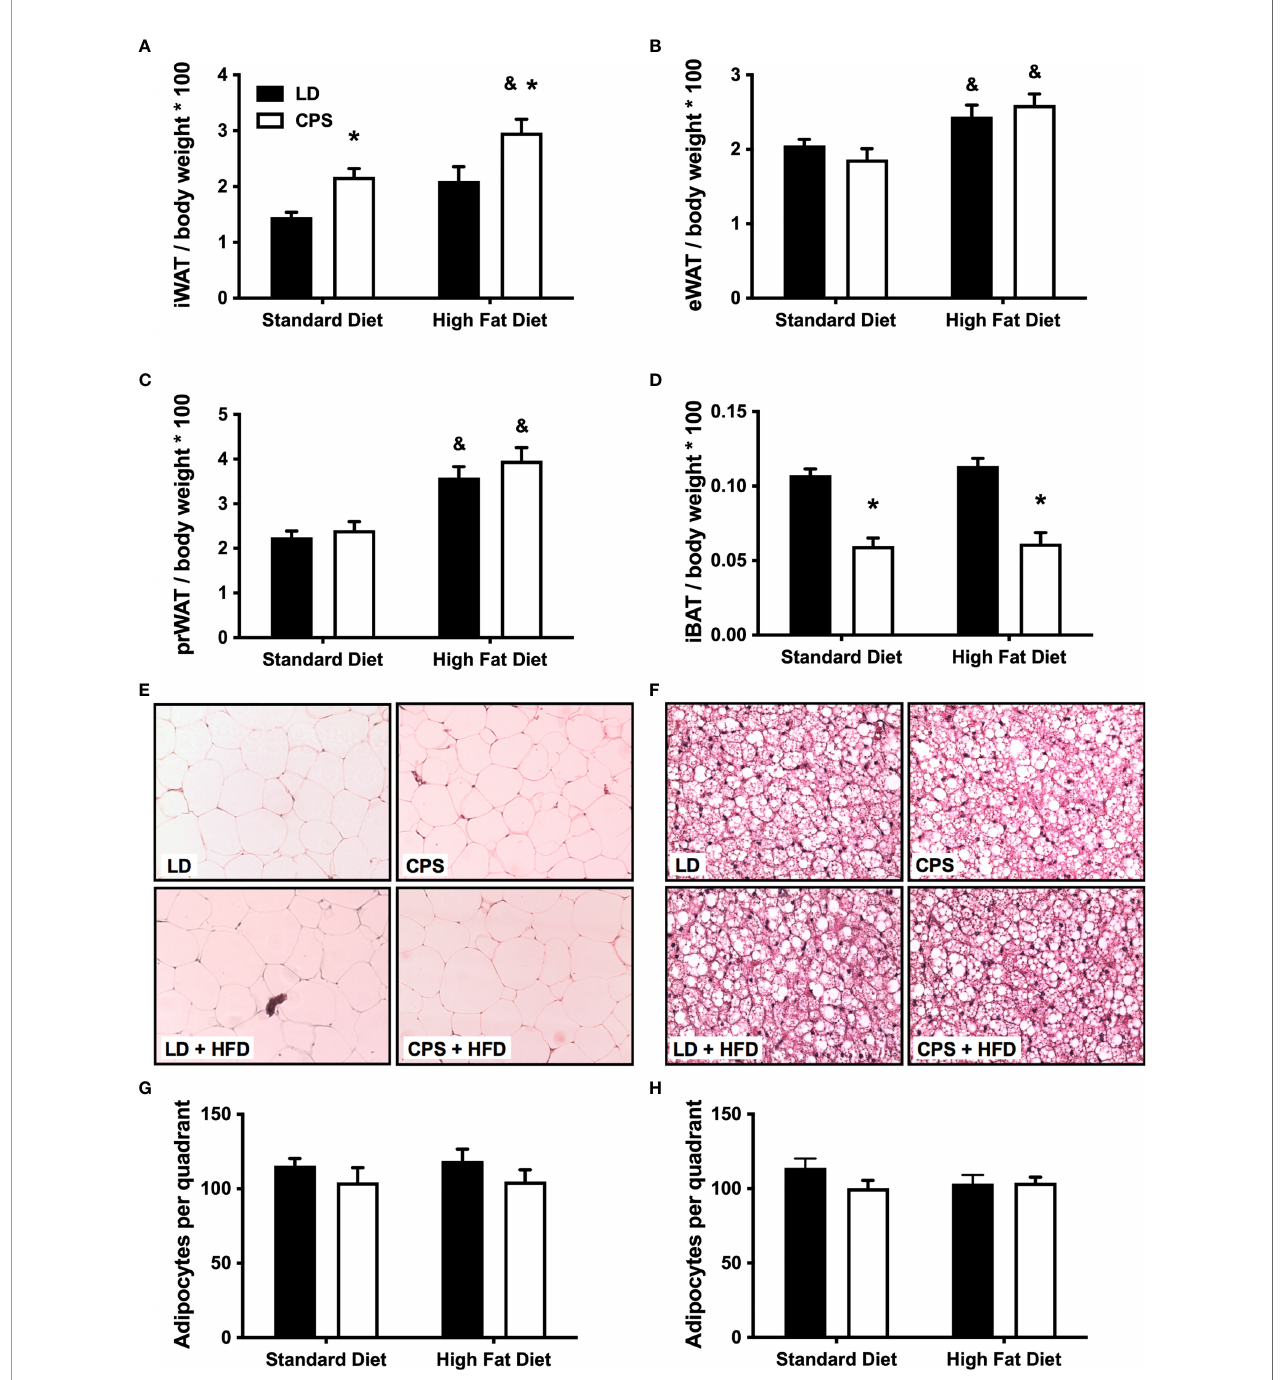
FIGURE 6 | Effects of gestational chronic phase shift of photoperiod in recruitment of adipose tissue depot. Upper panel displays the weight of whole adipose tissue depots adjusted by full-body weight of 200-day-old rats fed with standard diet or high-fat diet. (A) Inguinal adipose tissue, (B) epigonadal adipose tissue, (C) perirenal adipose tissue, (D) interscapular brown adipose tissue. Middle panel displays representative H&E staining of (E) 10× perirenal white adipose tissue and (F) 40× interscapular adipose tissue histological sections. Lower panel displays the corresponding cell number counts as shown in (G) from white adipose tissue and (H) from brown adipose tissue. Data are mean±SEM. Black bars: LD, adult rats that had been gestated under control 12:12 (LD) photoperiod. White bars: CPS, adult rats that had been gestated under chronic phase shift (CPS) photoperiod. Standard diet: animals fed with Prolab ® RMH 3000, High-fat diet: animals fed with 45% high-fat diet for 12 weeks. n = 8 per group. *LD + HFD; CPS + SD and CPS + HFD are different from LD + SD ( p < 0.05 pairwise comparison at each time point with Bonferroni correction). & Different from standard diet ( p < 0.05 pairwise comparison at each time point with Bonferroni